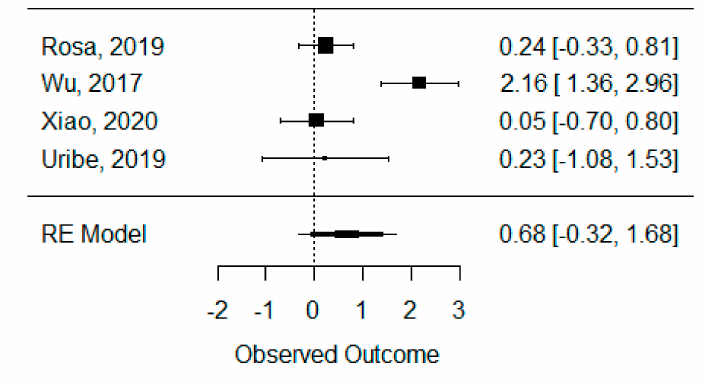
Figure 3. Forest plot for the standardized mean difference obtained for bone formation percentage analysis synthetic measures reported in the included systematic